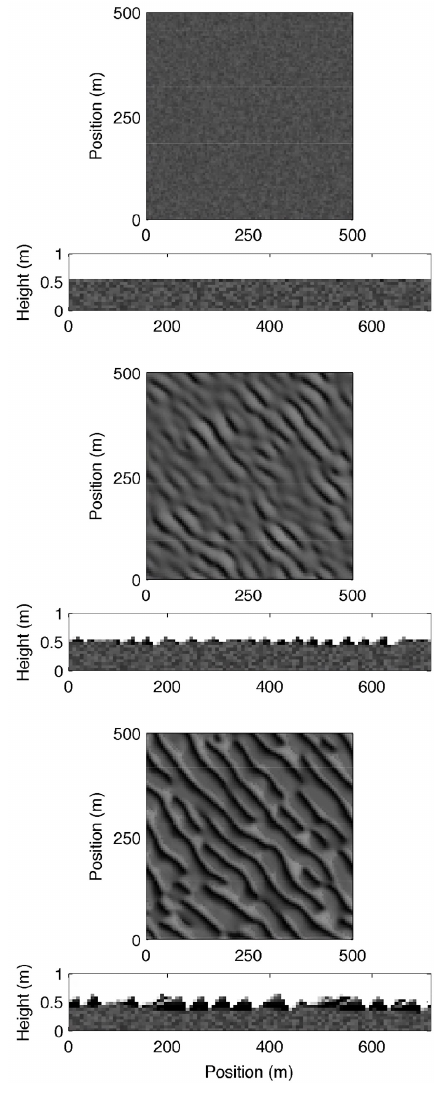
Figure 7. Plan view and profile view of sorted bedform model output (note the vertical exaggeration of profile view). Black and white pixels indicate fine ( d fine = 0 . 0002m) and coarse ( d coarse = 0 . 0005m) sediment, respectively. Current direction is from lower left to upper right and the profile is taken along this axis. The well- mixed and flat initial condition is shown in the top panels. Sorted bedforms appear within 50 days (middle panels) and are well de- veloped by model day 100 (bottom panels). These are mode 2 bed- forms; note that coarse domains appear on the updrift flank of the bedforms and wavelength and height are relatively small